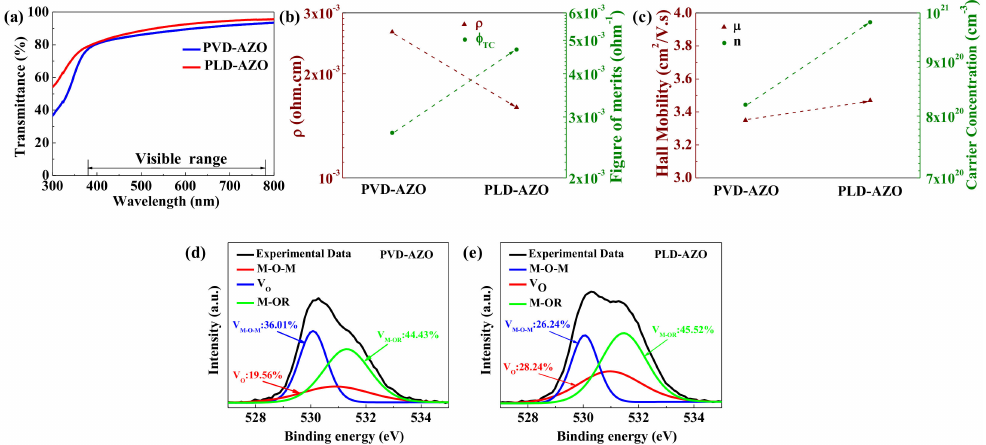
Figure 3. ( a ) The transmittance in the wavelength range of 300 nm–800 nm for PVD-AZO and PLD-AZO; ( b ) resistivity ( (cid:36) ) and the figure of merits ( Φ TC ) of PVD-AZO and PLD-AZO; ( c ) carrier concentration (n) and Hall mobility ( µ ) of PVD-AZO and PLD-AZO; the O1 s region of XPS spectra for ( d ) PVD-AZO and ( e )